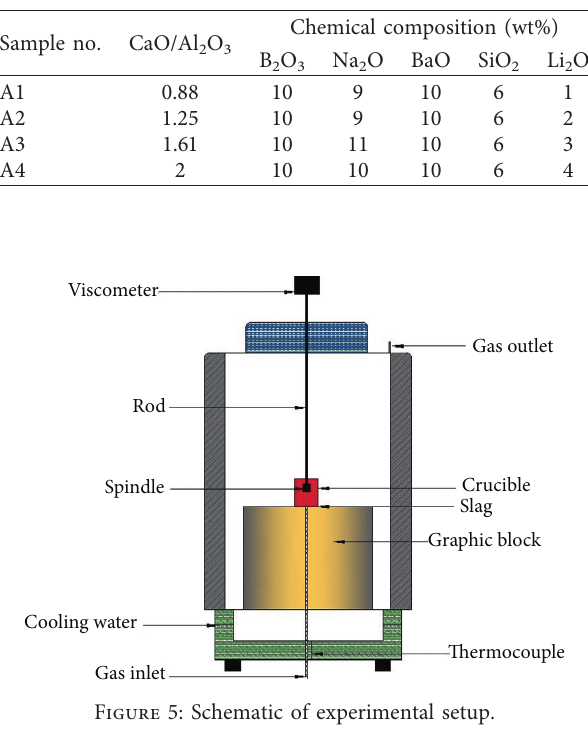
Table 3: The chemical composition of the CaO-Al fluxes.